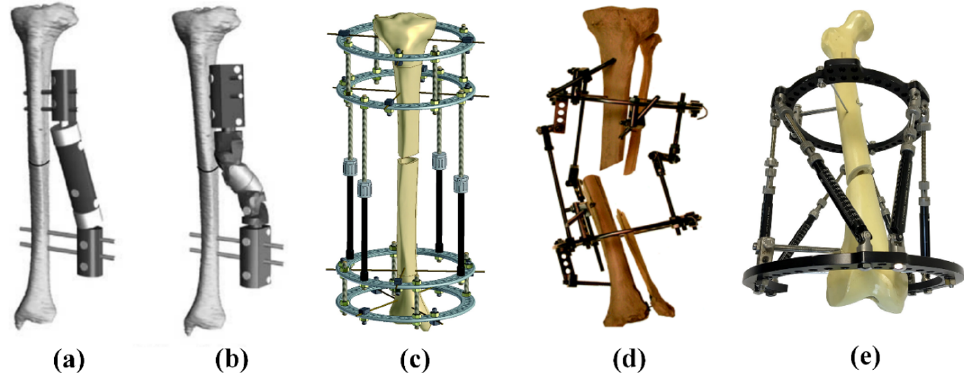
Figure 2. Examples of bone reduction mechanism. (a) Orthofix fixator (Kim et al., 2002); (b) Dynafix fixator (Kim et al., 2002); (c) Ilizarov apparatus (Zamani and Oyadiji, 2009); (d) Ortho-SUV Frame (Solomin, 2013); (e) Taylor Spatial Frame (Mackie Orthopaedics, 2016).